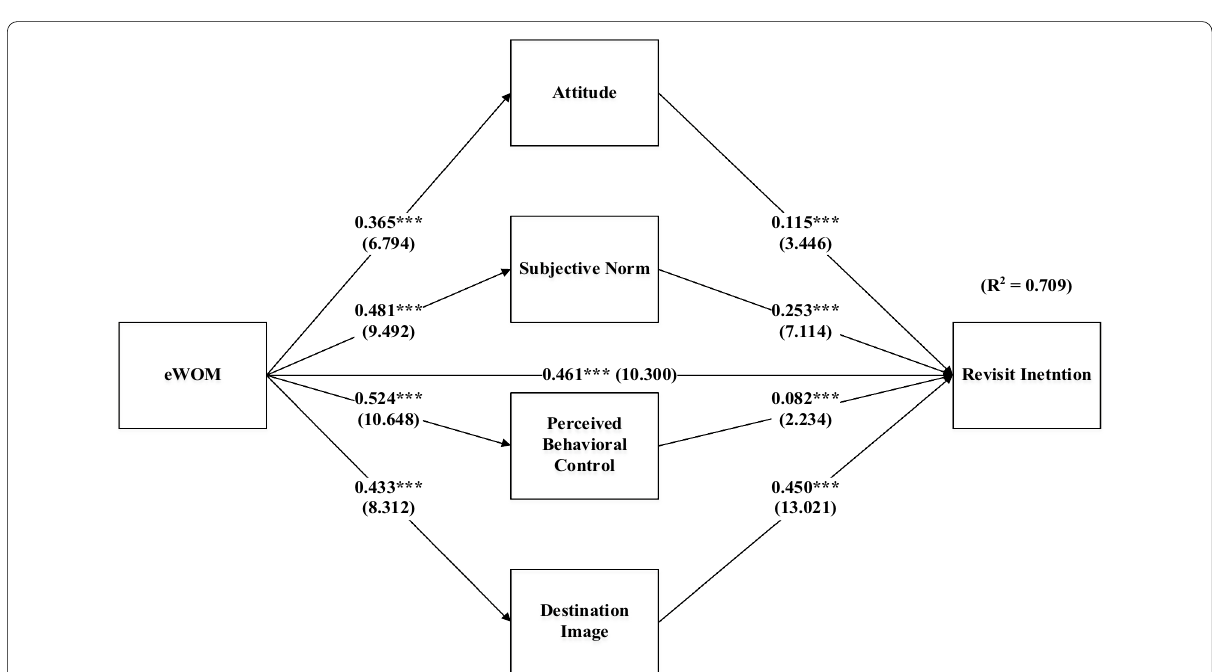
Fig. 2 Structural model and hypotheses. Source : AMOS